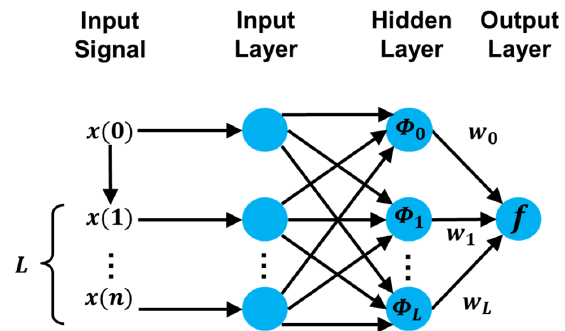
Figure 9. Structure of RBF-NN.